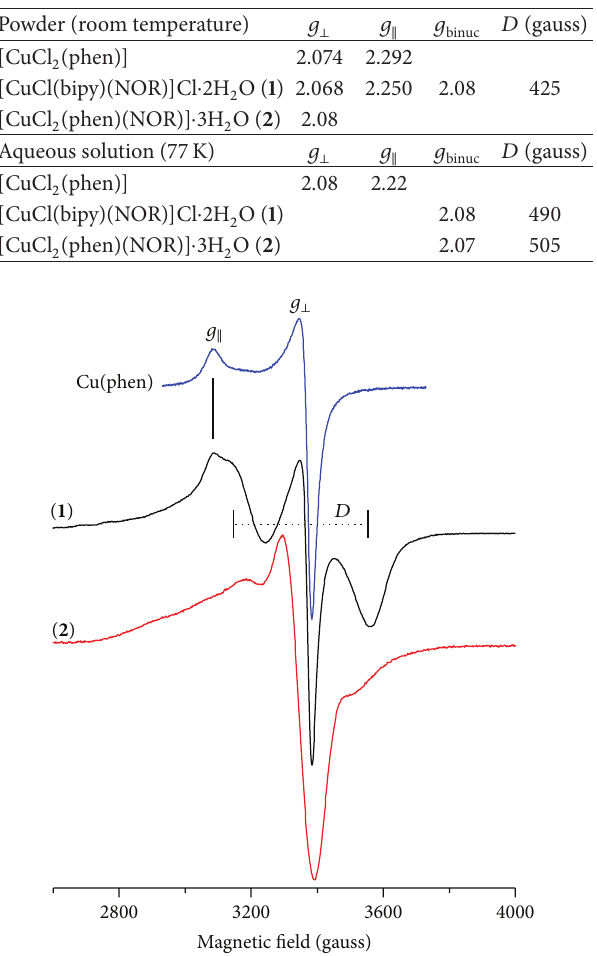
Table 1: EPR parameters of the Cu(II) complexes.